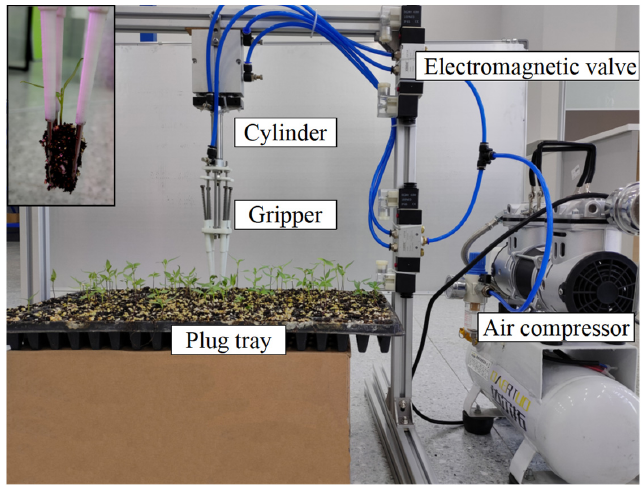
Figure 5. Grasping test of seedling gripper.